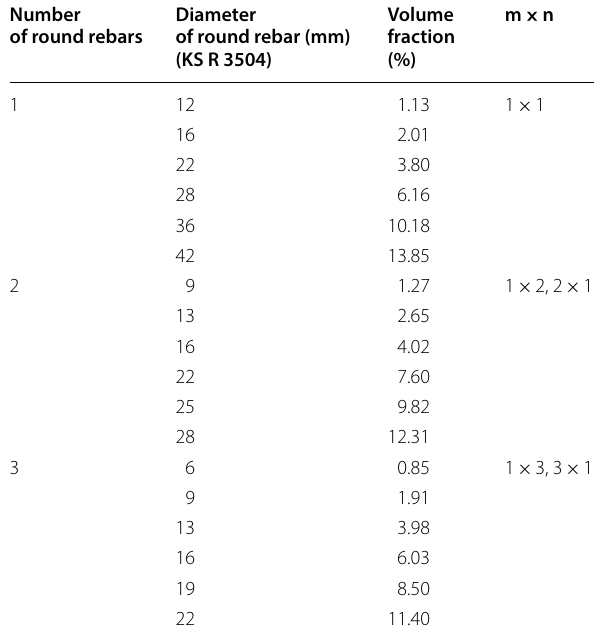
Table 2 Test cases for the numerical simulations of k in reinforced concrete.